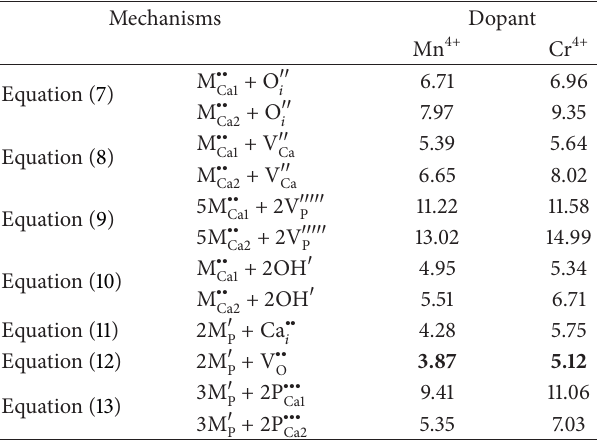
Table 8: Solution energies (eV) for different dopants in HAP.